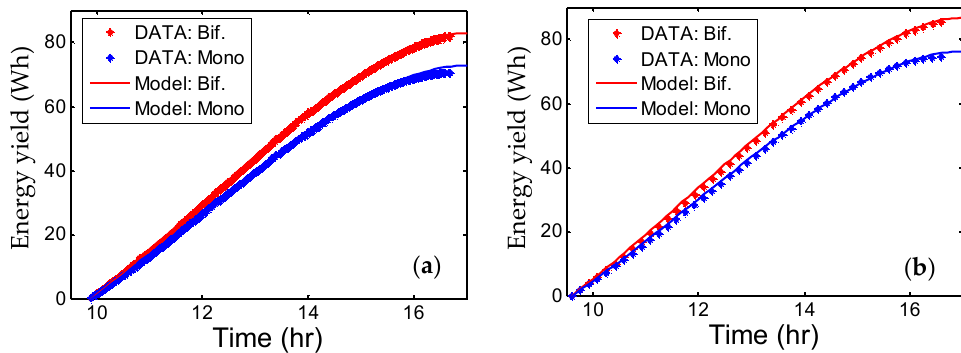
Figure 7. Data of a single day of module energy yield compared with the values predicted by the model ( a ) and average values compared with the model ( b ).